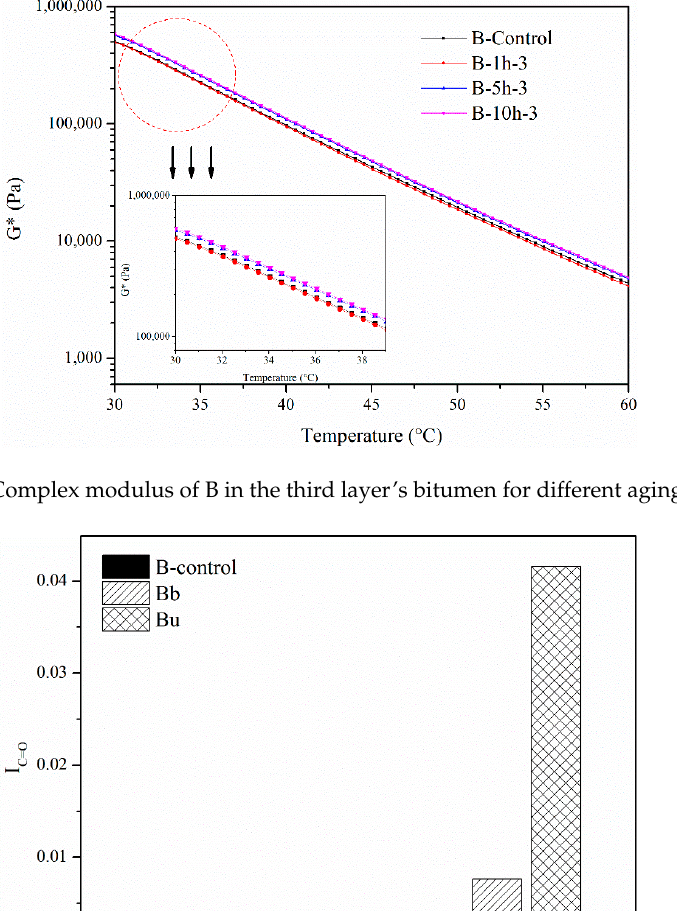
C=O of the second group before and after UV aging. Materials 2018 , 11 , x FOR PEER REVIEW